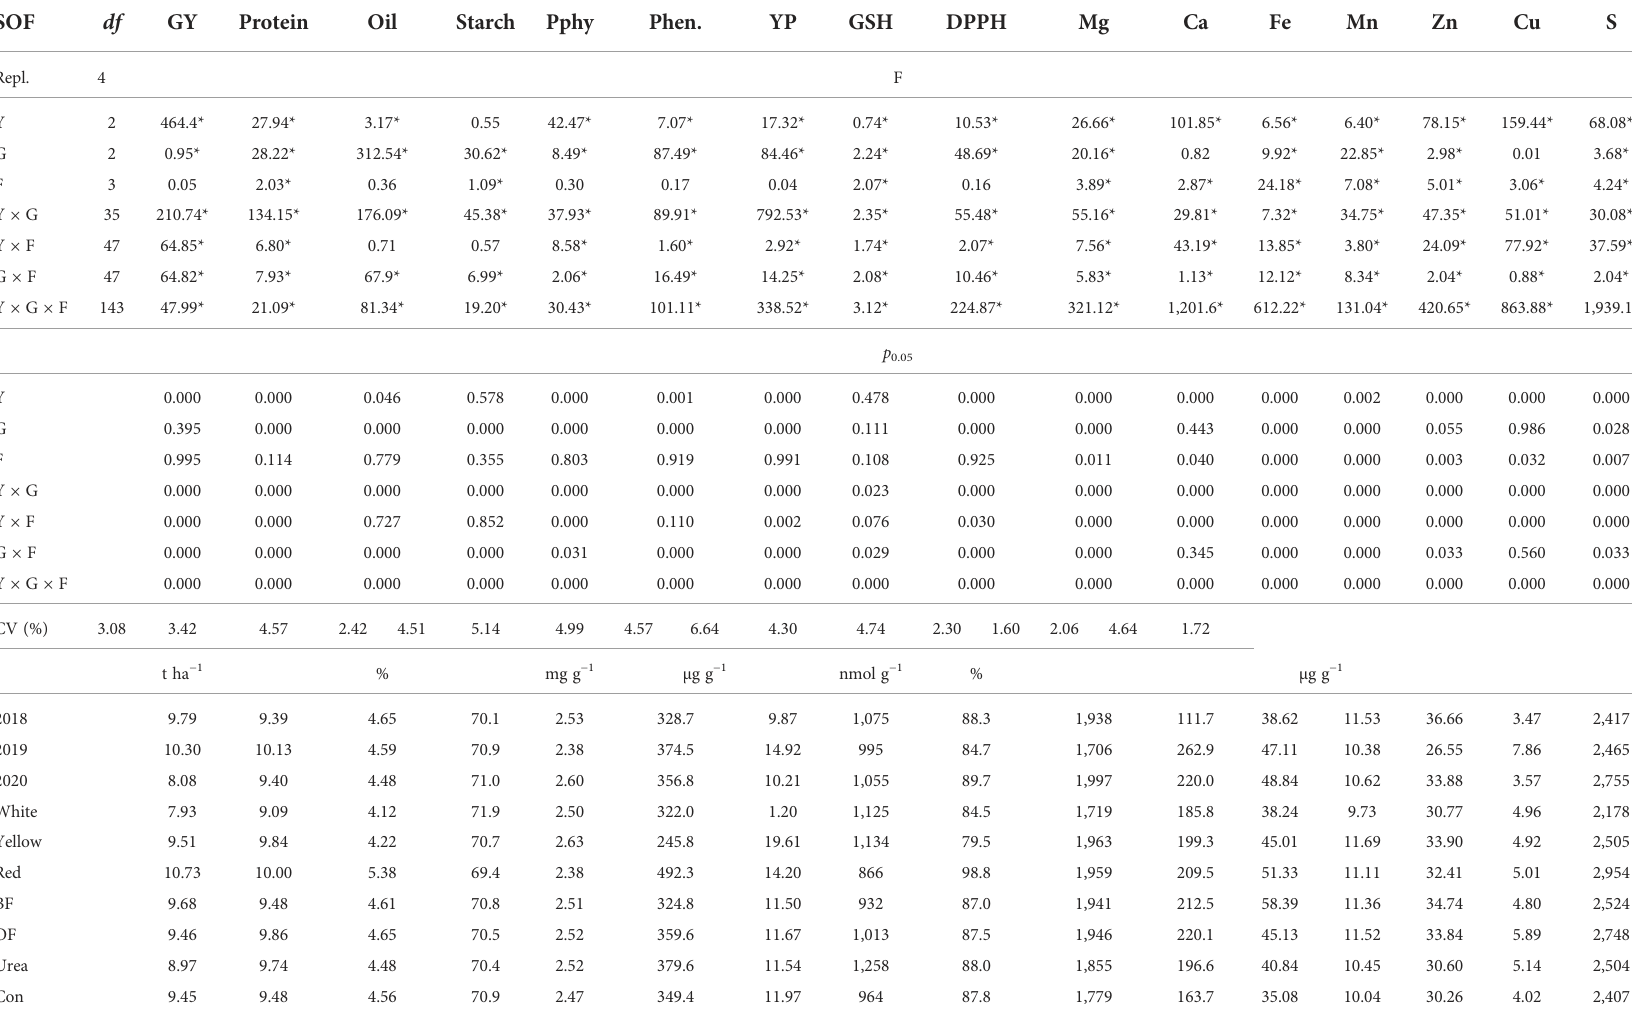
TABLE 3 The analysis of variance includes the effect of the year (Y), fertilizer treatment (F), genotype (G), and their interaction on the grain yield (GY), protein, oil, starch, phytic phosphorus (Pphy), phenolics (Phen), yellow pigment (YP), and glutathione (GSH) contents, reduction capacity of the DPPH radical (DPPH), and concentrations of Mg, Ca, Fe, Mn, Zn, Cu, and S in maize grains with different kernel